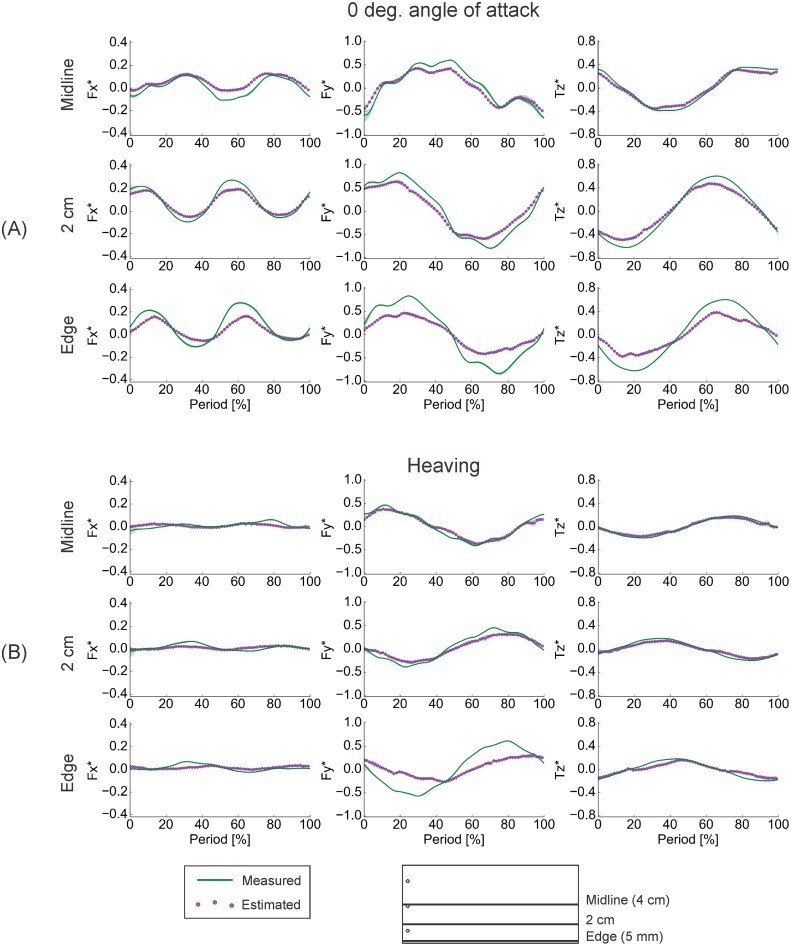
Results of three-dimensional testing of the rectangular foil.Comparisons of phase-averaged (n = 3) measured and calculated force and torque time traces reveal that the pressure-based force calculation was generally able to accurately reproduce both the shape and magnitude of the measured trace, although the agreement declined with proximity to the foil’s edge. (A) Results from 0° angle of attack motions. Due to unusual oscillations resulting from a loose screw, midline data were replaced with equivalent data from dynamic testing. (B) Results from heaving motions. Fx − streamwise forces. Fy − lateral forces. Tz − torques about the vertical axis. Foil kinematics corresponded with the 1.5 Hz cases in dynamic testing (see Figs 10 and 11). Silhouettes represent standard deviations.